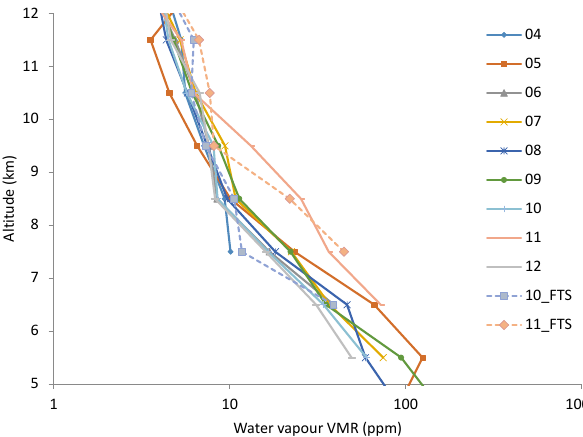
Figure 7. Relative humidity for July 2011 (40–60 ◦ S, N = 52, and 60–66 ◦ S, N = 111) and climatology (60–66 ◦ S, July for every year, except 2011 between 6.5 and 9.5km, N = 865) determined from MAESTRO water vapour and co-located GEM analysis tempera- ture and pressure (Laroche et al., 1999). The uncertainty on the cli- matologic RH accounts for interannual variability in water vapour and saturated water vapour mixing ratio, combined in quadrature. The error bars in the July 2011 RH profiles only account for the standard error of the monthly mean water vapour.